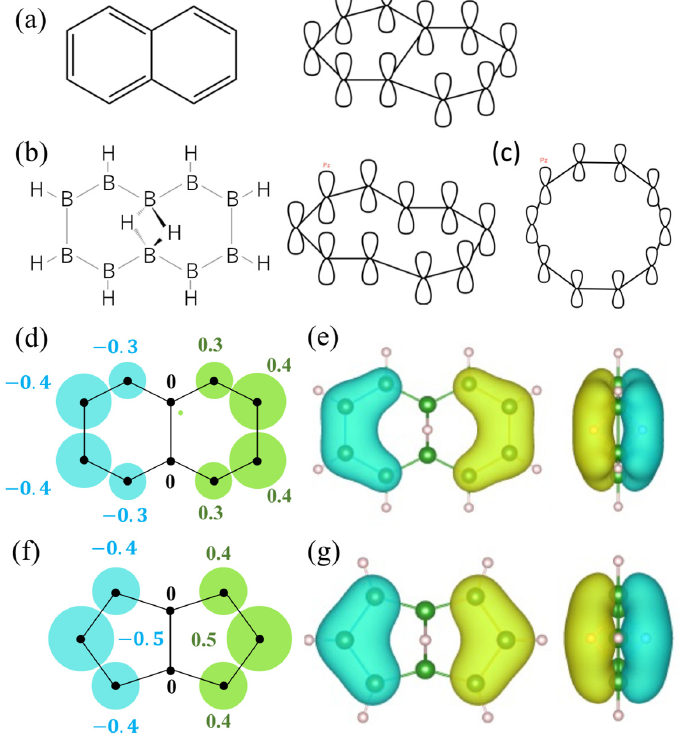
Figure 7. Application of the Hückel model to cyclic molecules. ( a ) Naphthalene molecule and the p z configuration. ( b ) 1,6-1,6-decadiborane and the p z configuration. ( c ) p z configuration of a cyclic decagon molecule. ( d , e ) Molecular orbitals of 1,6-1,6-decadiborane, calculated from ( d ) the Hückel model and ( e ) first-principles calculations. ( f , g ) Molecular orbitals of 1,5-1,5-octadiborane, calculated from the ( g ) Hückel model and ( f ) first-principles calculations. The color of each molecular orbital corresponds to the sign of its wave functions.